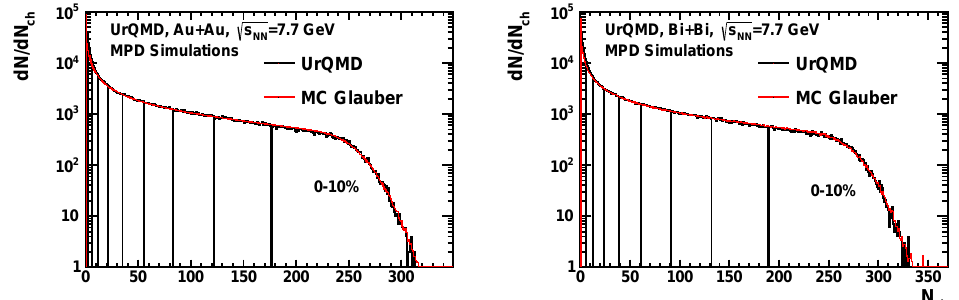
Figure 3. Track multiplicity distribution from the fully reconstructed Ultra-relativistic Quantum Molecular Dynamics (UrQMD) events for Au + Au ( left panel) and Bi + Bi ( right panel) collisions at √ s NN = 7.7 GeV compared to the fitted distribution using Monte Carlo (MC)–Glauber approach (red line). The 10% centrality classes defined with MC–Glauber normalization are indicated with black vertical